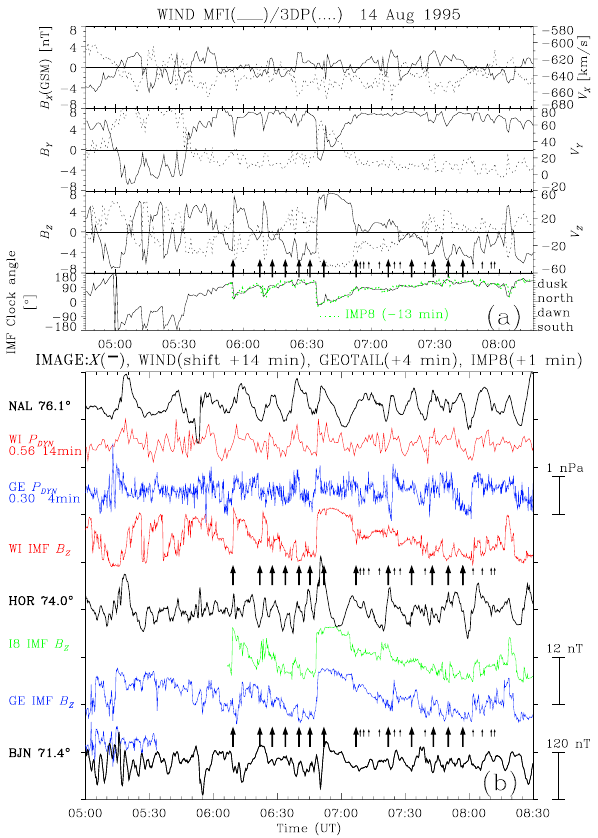
Fig. 7. (a) Alfv´enic fluctuations observed in the solar wind mag- netic field (solid lines) and ion velocity (black dotted lines) ob- served by WIND. The bottom panel shows the IMF clock angle for WIND and IMP-8 (green). (b) The detrended X component ground magnetic field (black), measured by the IMAGE (Svalbard) mag- netometer, array and the detrended and shifted solar wind dynamic pressure P DYN , measured by WIND (red) and GEOTAIL (blue), are shown (average correlation coefficients and lags are shown on the left). In addition, the time shifted IMF B Z for WIND (red), GEOTAIL (blue), and IMP-8 (green) are superposed. The large and small arrows indicate the onset times of major and minor PIFs, re-